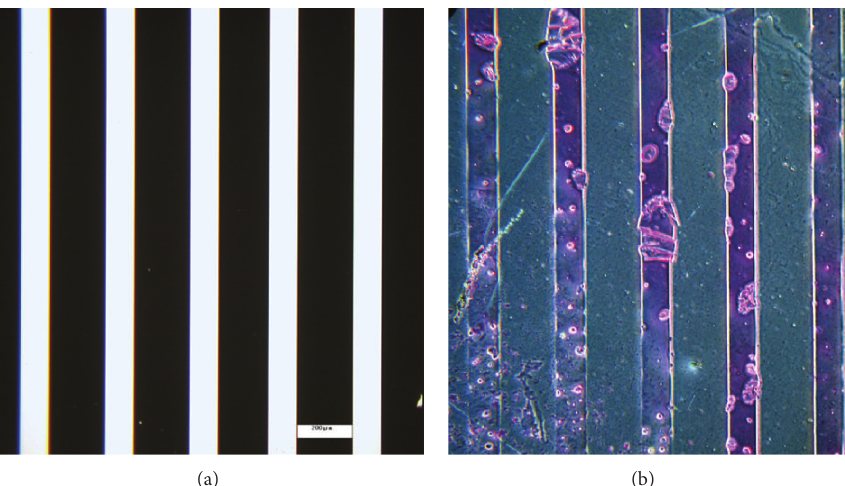
Figure 1: Photomask (a) and micropatterned azidophenyl low-molecular-weight chitosan (P-ALMC) after UV irradiation (b). The pattern of P-ALMC shows that P-ALMC reacted after irradiation with UV light and became insoluble in water, in contrast to the soluble nonirradiated azidophenyl chitosan, is the same as the photomask.